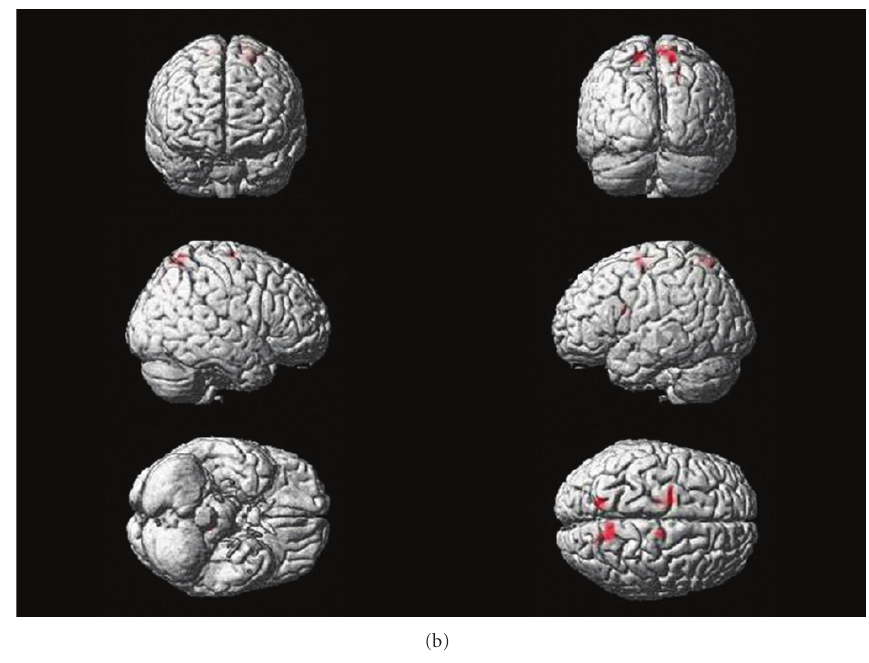
Figure 4: Significant activated areas of test period compared to baseline period (for more details, see